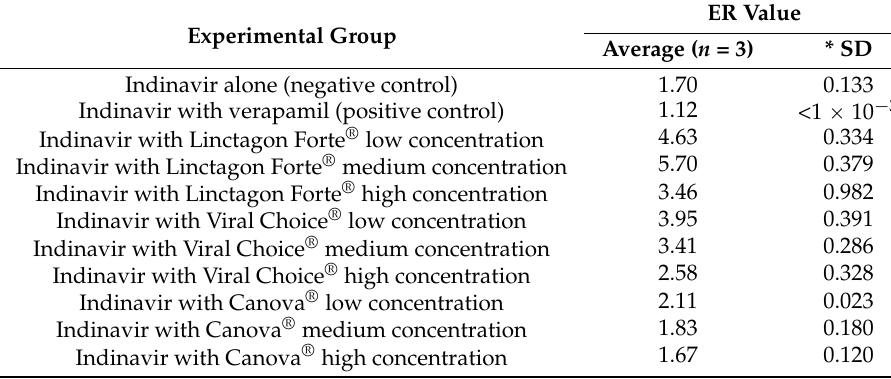
Table 1. Efflux ratio (ER) values for indinavir in the presence of the selected herbal products and control groups.